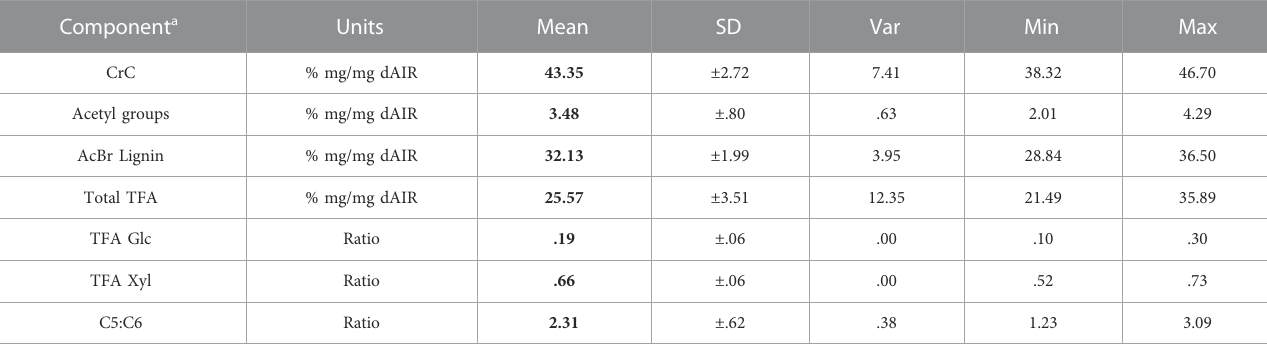
TABLE 1 The average content of measured cell wall components of rapeseed straw.